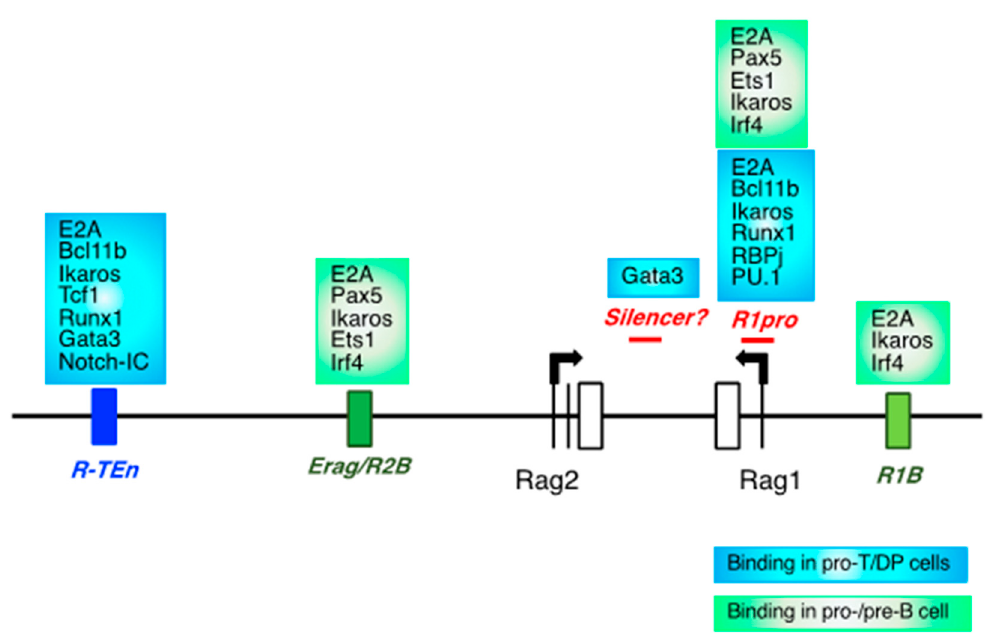
Figure 1. Rag gene enhancers in developing T and B cells. A schematic diagram of Rag gene locus and enhancers in developing T and B cells. The blue box indicates T cell-specific enhancer (R -TEn ) and TF binding in pro-T and DP cells. The green boxes indicate B cell-specific enhancers ( R1B and R2B ) and TF binding in pro-/pre-B cells. The red lines indicate the Rag1 -promoter region ( R1pro ) and silencer ( Silencer ) of Rag gene, respectively.